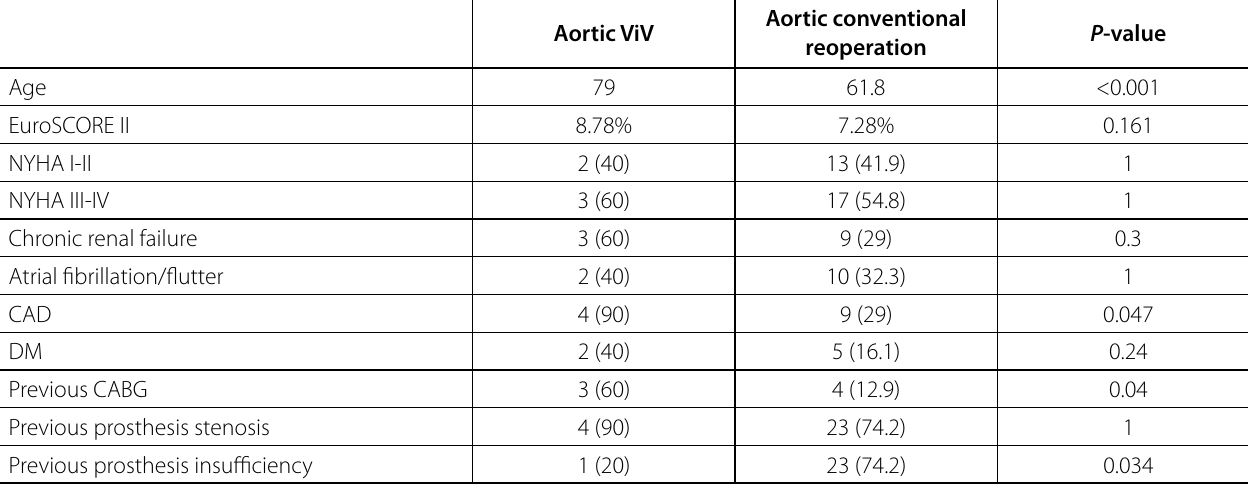
Table 3 . Preoperative characteristics comparison between 5 aortic ViV patients and 31 conventional aortic